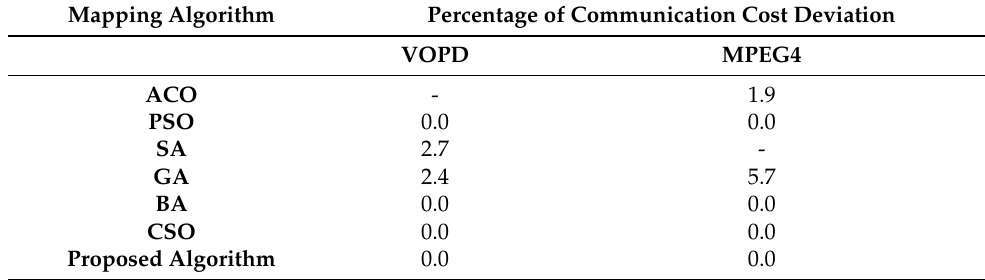
Table 5. Percentage deviation over ILP based mapping techniques.